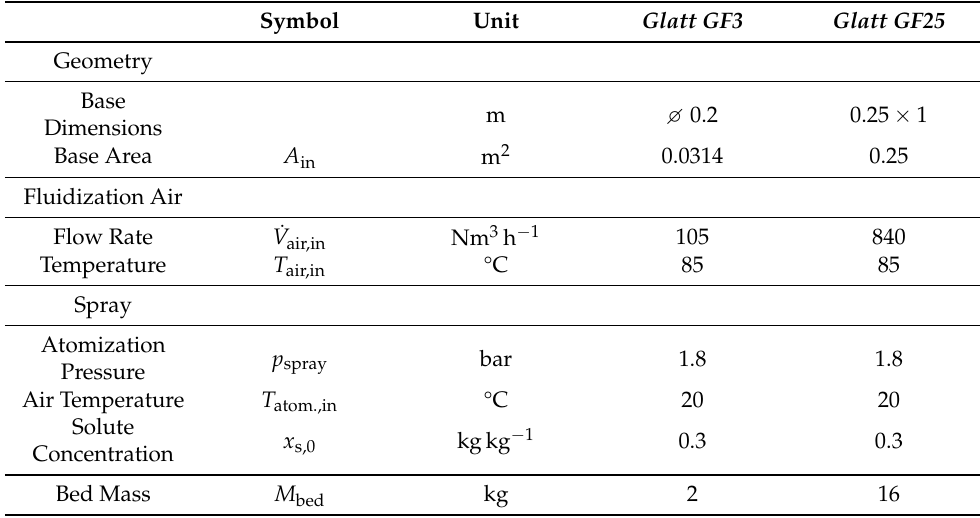
Table 3. Geometric parameters and process conditions used in the scale-up. Symbol